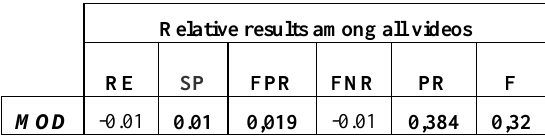
Table 5. Comparison of algorithms results for all videos